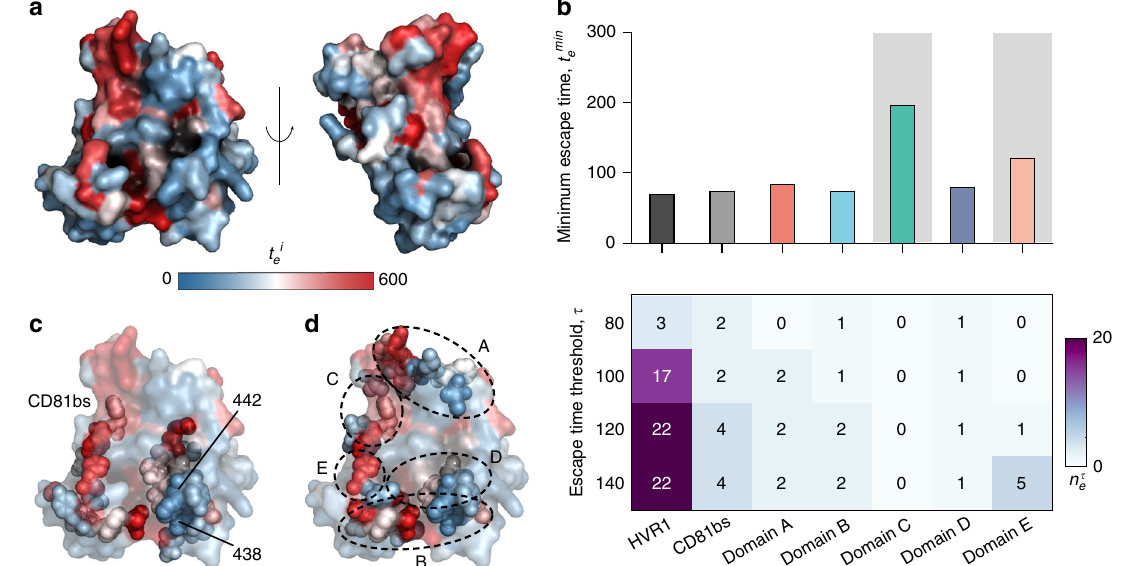
Fig. 3 Superimposing relative escape times on the available E2 crystal structure reveals dif fi cult to escape regions for antibody targeting. a Residues incurring high escape times upon mutation (large values of t i e ) are shown in red and those associated with low escape times (small values of t i e ) are shown in blue. The crystal structure 43 was obtained from the protein data bank with PDB ID 4MWF. Left and right panels show the front and side views of E2, respectively. b Analysis of minimum escape time across all residues t min e (top panel) and number of residues with relatively short escape times n τ e (bottom panel) in E2 regions that are targeted by antibodies. Among all domains accessible to antibodies, antigenic domains C and E (shaded) have t min ζ (102 generations) and are thus predicted to be dif fi cult to escape. Domain C, in particular, is predicted to be the most escape resistant. c Escape e > times superimposed on the crystal structure with CD81 binding sites highlighted as spheres. Speci fi c residues (438 and 442) associated with low escape times in CD81 binding sites are also highlighted on the fi gure. d Escape times superimposed on the crystal structure with antigenic domains A – E highlighted as spheres. Approximate location of speci fi c antigenic domains is shown by dotted ellipses. HVR1 and a large part of domain E is not shown as the